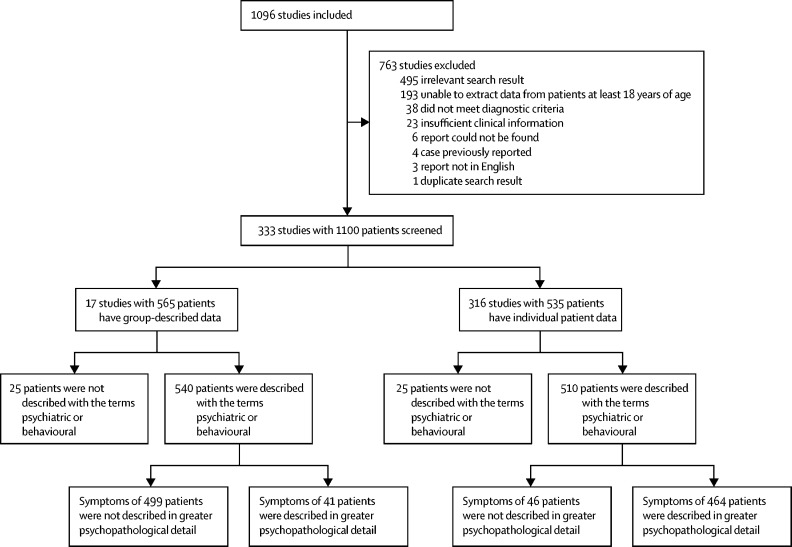
Study selection